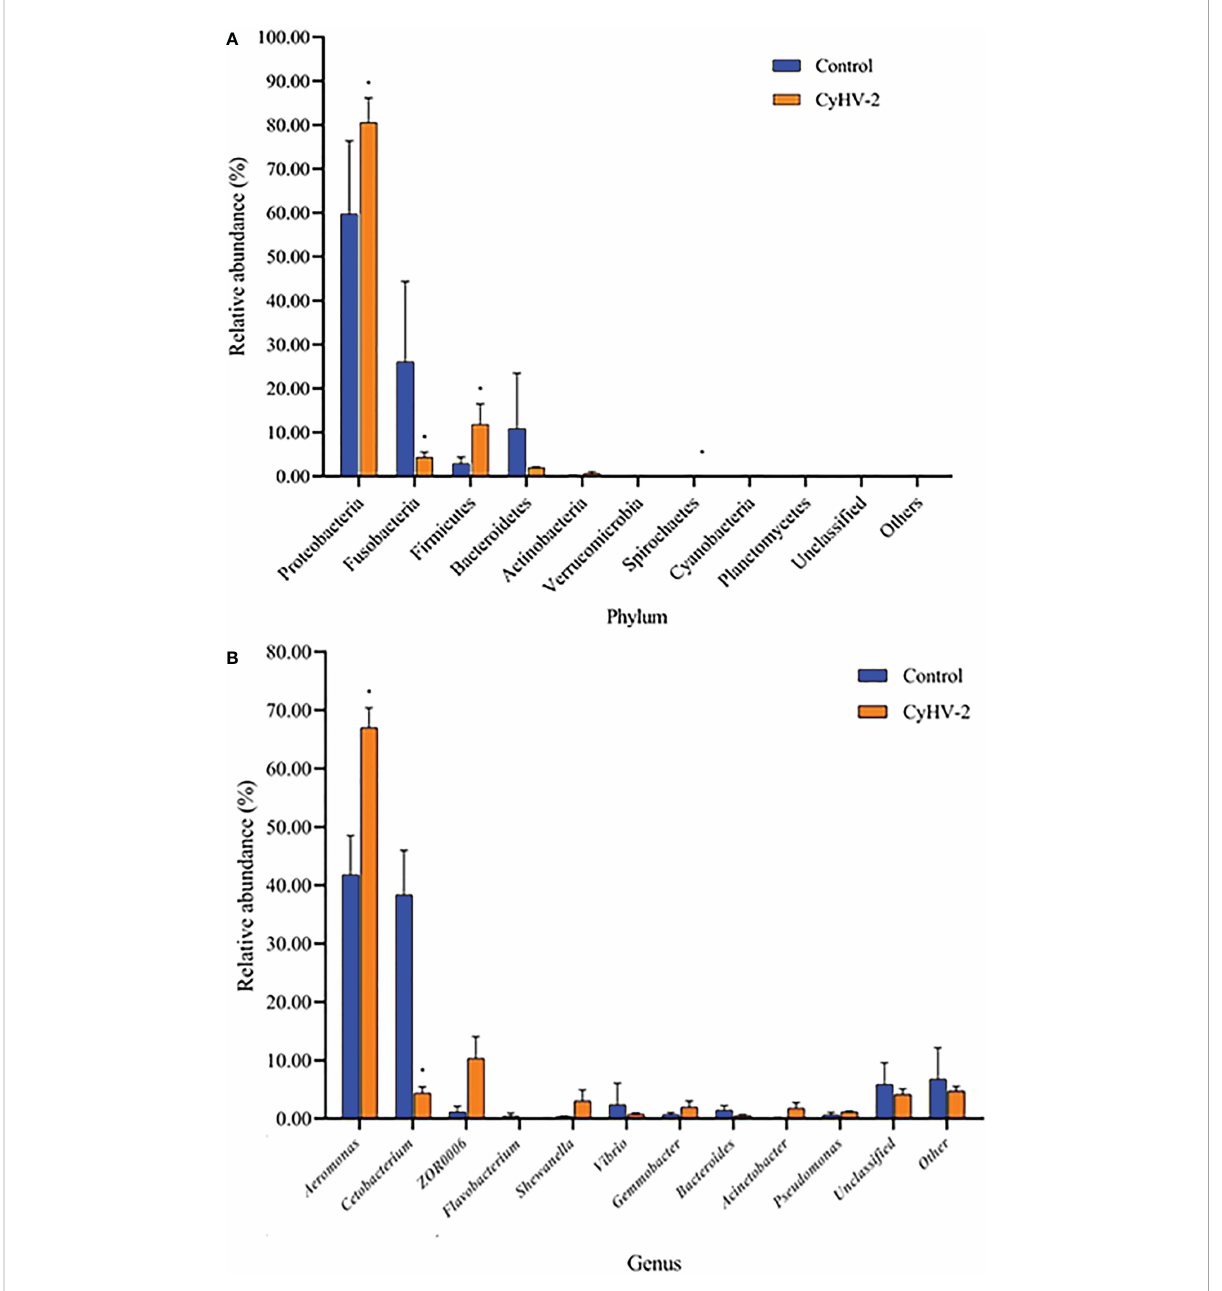
FIGURE 3 The gut microbiome composition individual pro fi les at the phylum (A) and genus (B) levels in the control and CyHV-2-infection groups. * means a signi fi cant difference between the two groups ( p